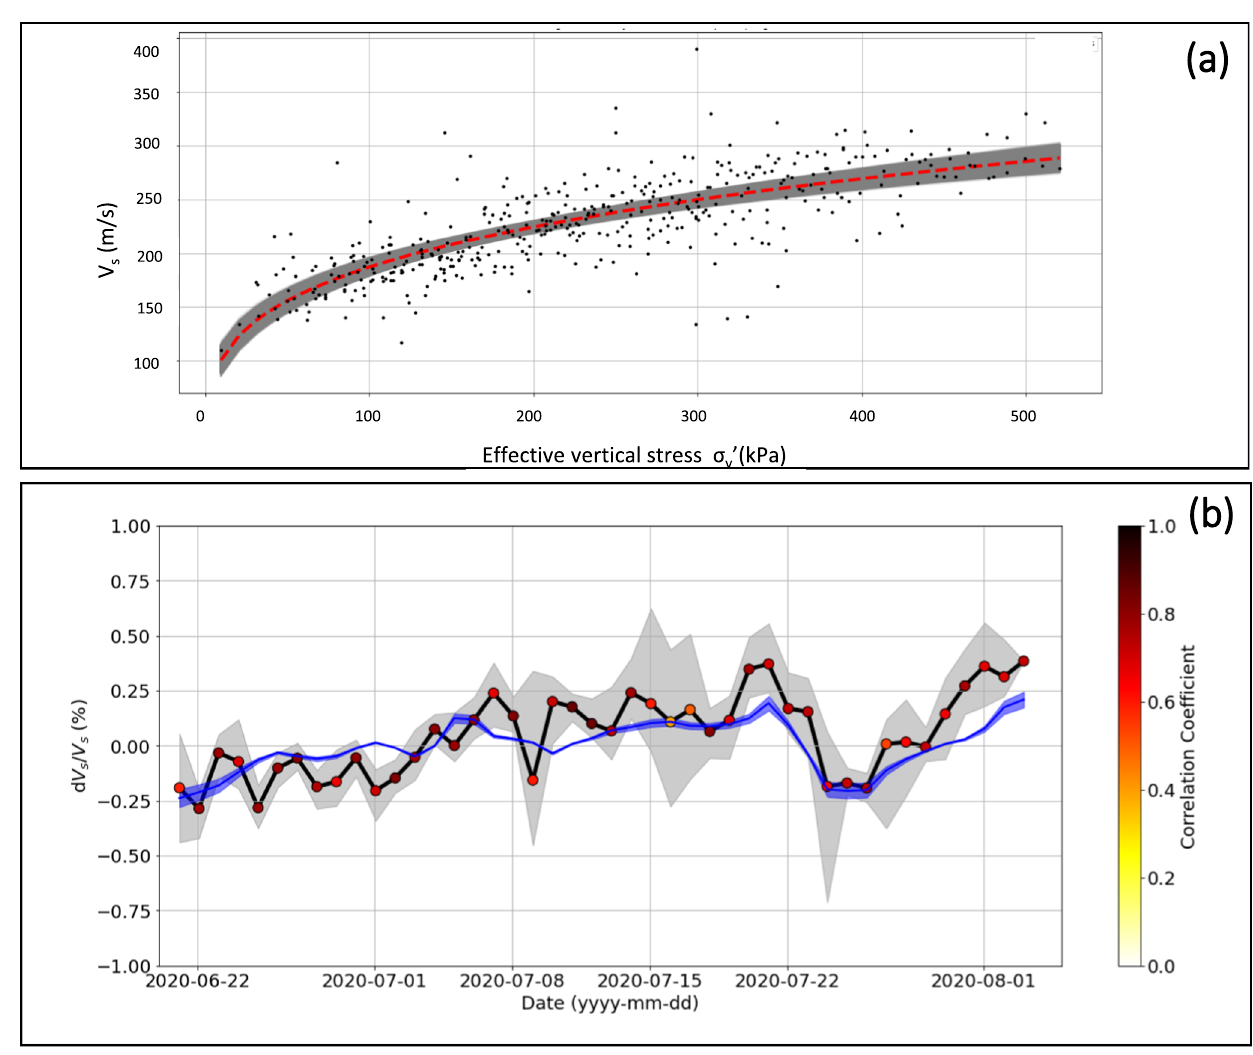
Fig. 4 Main result. a Estimation of site speci fi c α and β from power-law regression using V s estimates from sCPT surveys and effective vertical stress for underlying tailings material. Bootstrap analyses, shown in shaded gray, were used to obtain 95% con fi dence intervals of the α and β parameters. Regression results for compacted/coarse tailings and clay units are presented in Fig. 5. b Modeled dV s /V s based on α and β obtained from power-law regression for an optimized depth z in blue. Shaded blue area represents the maximum and minimum extents of 50,000 Monte Carlo simulations, and the blue line is the mean of all simulations. Average dv/v estimates over geophone array are shown as a black line, with gray shading representing maximum and minimum extents of individual virtual sources averaged over all receiver combinations. The average correlation coef fi cient, plotted as a marker, shown between the reference correlation waveform and the stretched waveform.